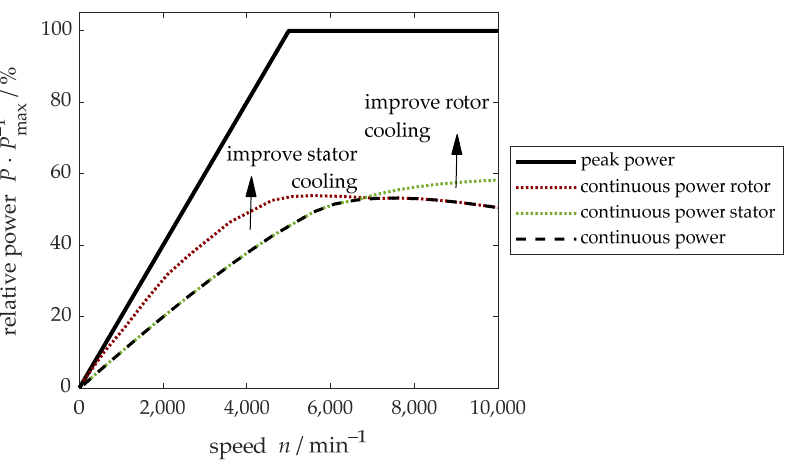
Figure 2. Schematic representation of the relative peak power and continuous power of a permanent magnet synchronous machine along with the theoretical limits if only stator windings or magnets were to be taken into account.